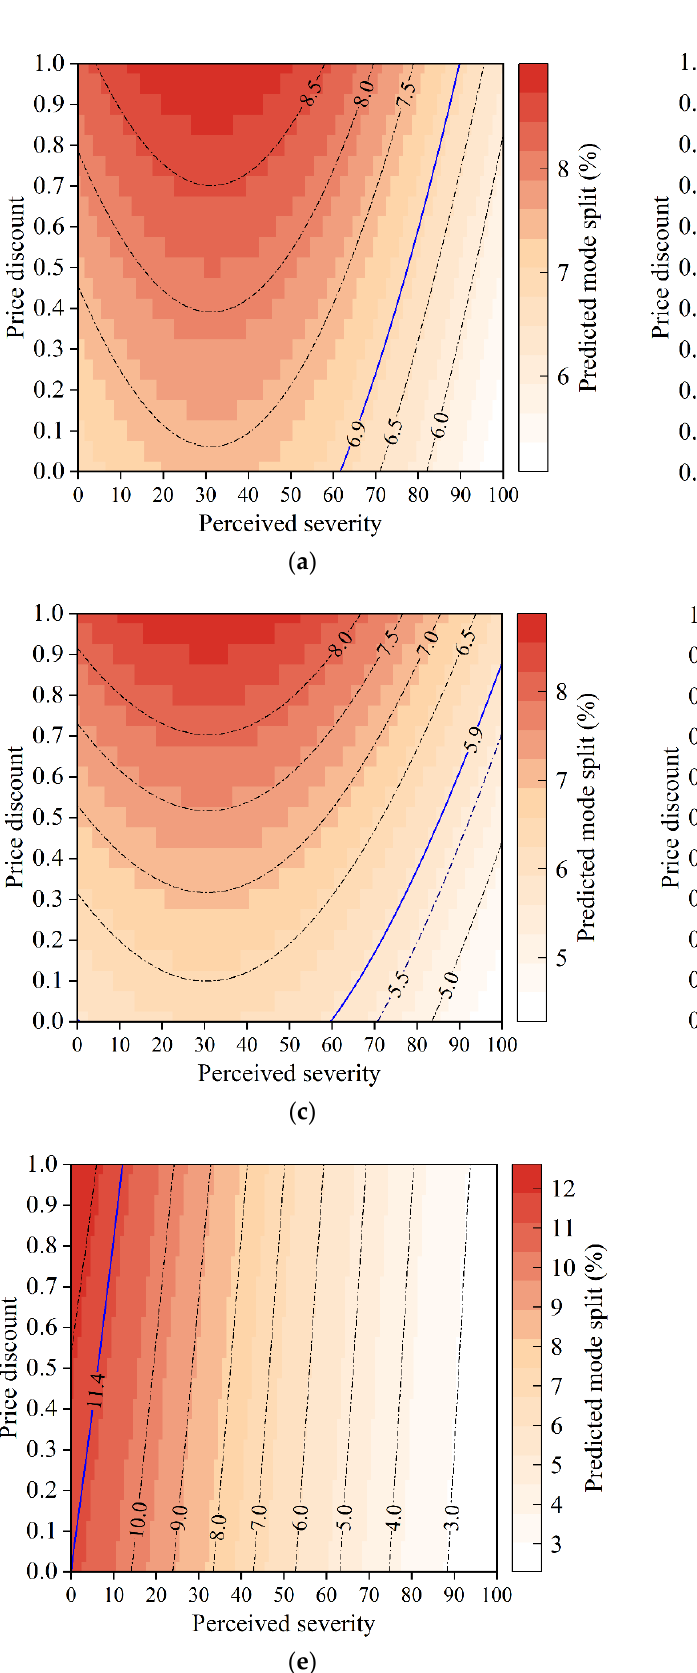
Figure 8. Mode split changes in ride hailing and ride sharing. ( a ) Ride hailing basis. ( b ) Ride hailing express. ( c ) Ride hailing premier. ( d ) Ride splitting. ( e ) Car pooling.